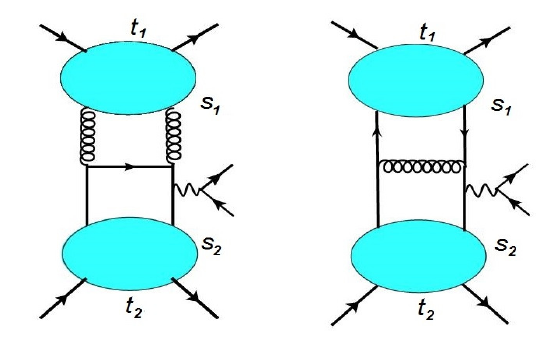
Figure 5. Drell-Yan process with gluon and quark